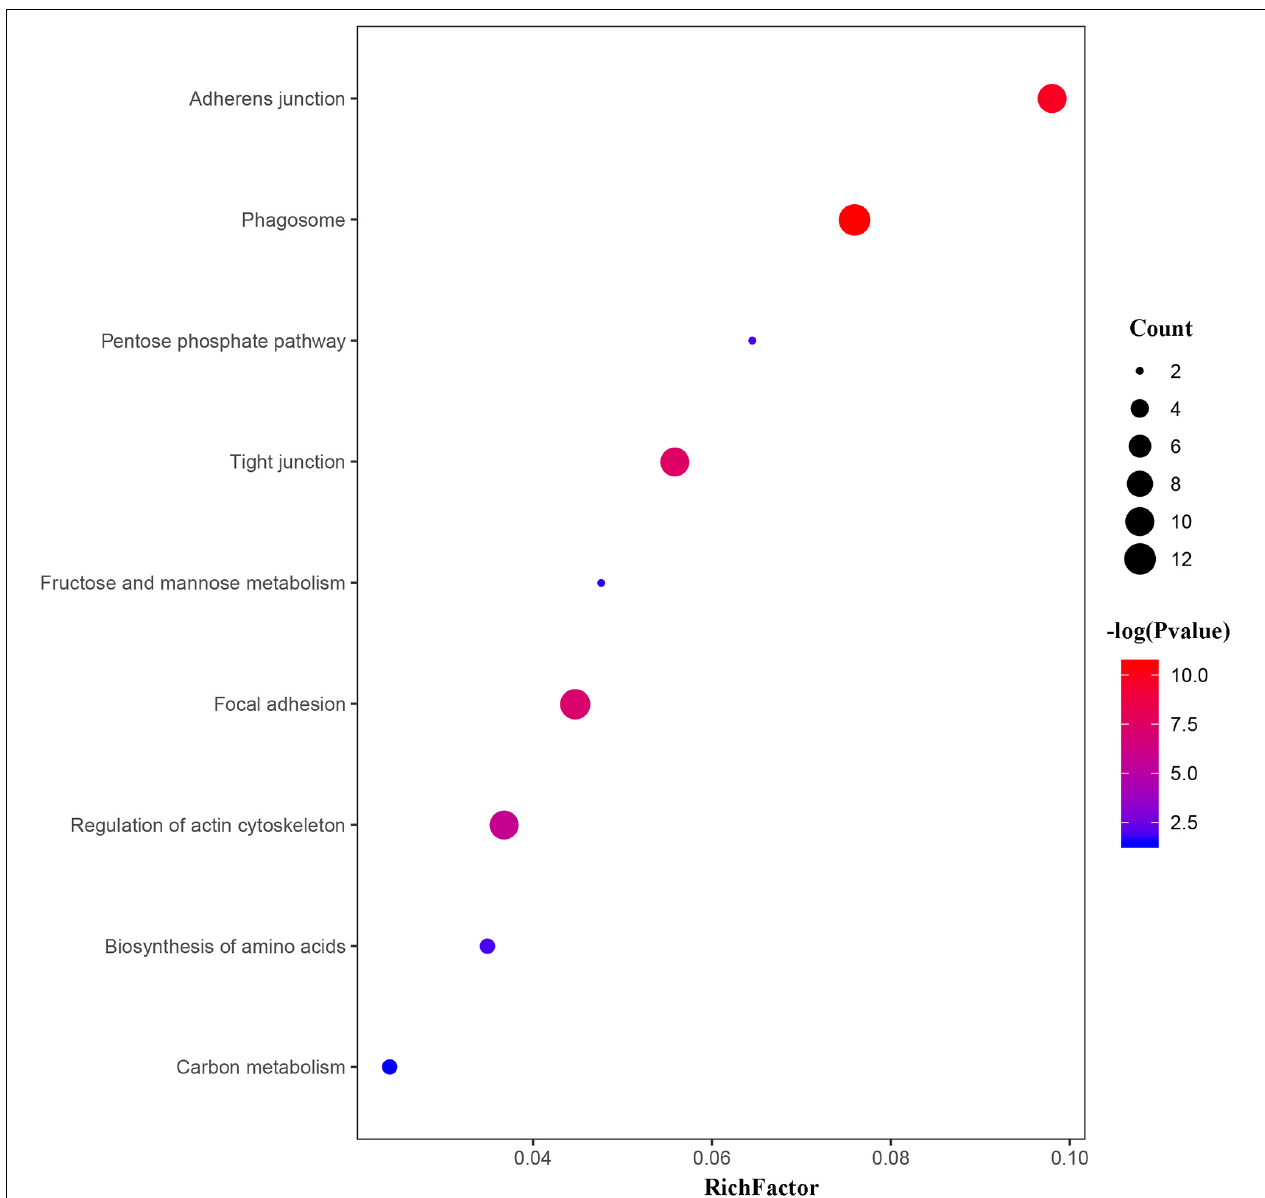
FIGURE 5 | Bubble chart showing the significantly enriched KEGG pathways in C. farreri exposed to OA ( p < 0.05). In the bubble chart, the vertical axis is the functional classification or pathway and the horizontal axis is the proportion of the different proteins in this functional type compared to the proportion of the identified protein. The color of the circle indicates the enrichment significance P-value, and the size of the circle indicates the number of differential proteins in functional classes or